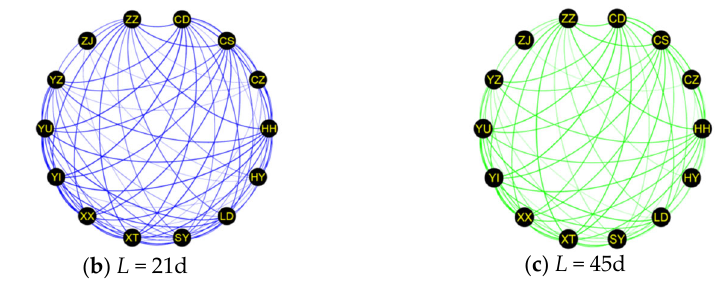
Figure 3. Networks graph of NO 2 at ( a ) small time scale, ( b ) medium time scale, and ( c ) large time scale.